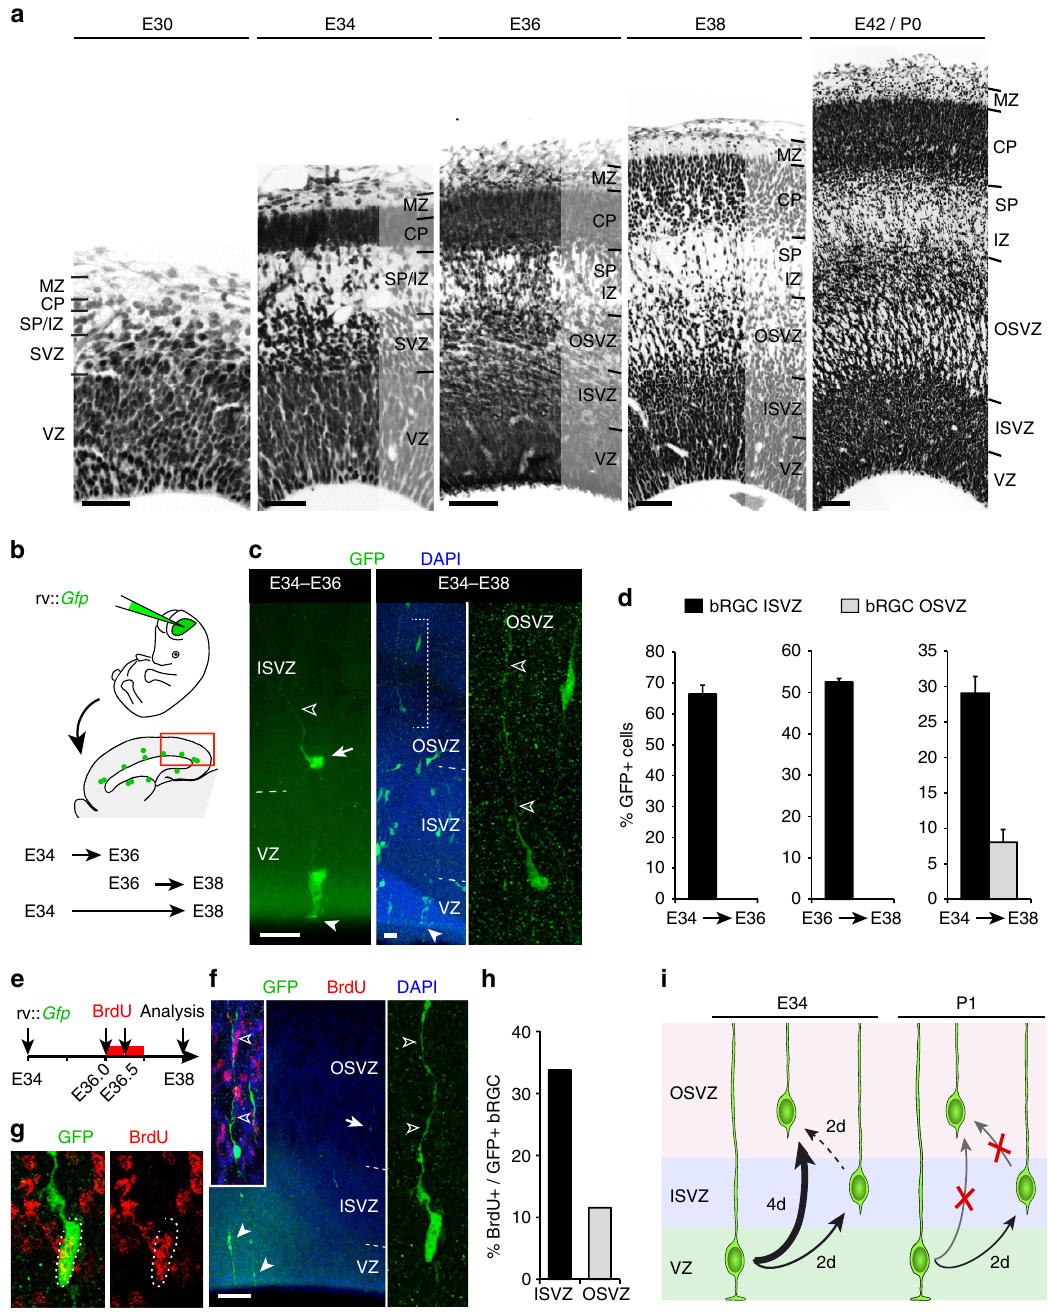
Figure 3 | Embryonic aRGCs generate directly bRGCs for the OSVZ. ( a ) Nissl stains of the ferret embryonic neocortex illustrate the developmental progression of germinal layers and the first histological recognition of OSVZ between E34 and E36. ( b – d ) Ferret embryos received a ventricular injection of rv:: Gfp at E34 or E36, and developed in utero until E36 or E38. GFP þ bRGCs were found in OSVZ after 4 days of survival (E34–E38, detail), but only in ISVZ after 2 days (E34–36, arrow; n ¼ 931 cells, 8 embryos; E36–38, n ¼ 104 cells, 2 embryos; E34–38, n ¼ 1,830 cells, 7 embryos; mean values þ s.e.m.). ( e – h ) VZ progenitors were labelled with rv:: Gfp at E34, BrdU was administered 2 days later and were analysed at E38 ( f , g ). Arrow in f points at the bRGC magnified in inset. Very few GFP þ bRGCs in OSVZ contained BrdU ( f , right; f , g ; n ¼ 229 cells, 5 embryos), indicating that most were directly generated from VZ. In c and f , solid arrowheads indicate aRGCs and open arrowheads indicate basal process of bRGCs. ( i ) At E34, aRGCs generate bRGCs that reach the ISVZ 2 days later (E36) and OSVZ 4 days later (E38). Few bRGCs in OSVZ are generated between E36 and E38 (likely from ISVZ), the majority being generated between E34 and E36 directly from VZ. Postnatally, aRGCs generate bRGCs for the ISVZ, but neither generates bRGCs for the OSVZ. Scale bar, 30 m m (E30 and E34; a ), 100 m m (E36; a ), 150 m m (E38; a ), 200 m m (E42/P0, a ); 25 m m ( c ); 150 m m ( f